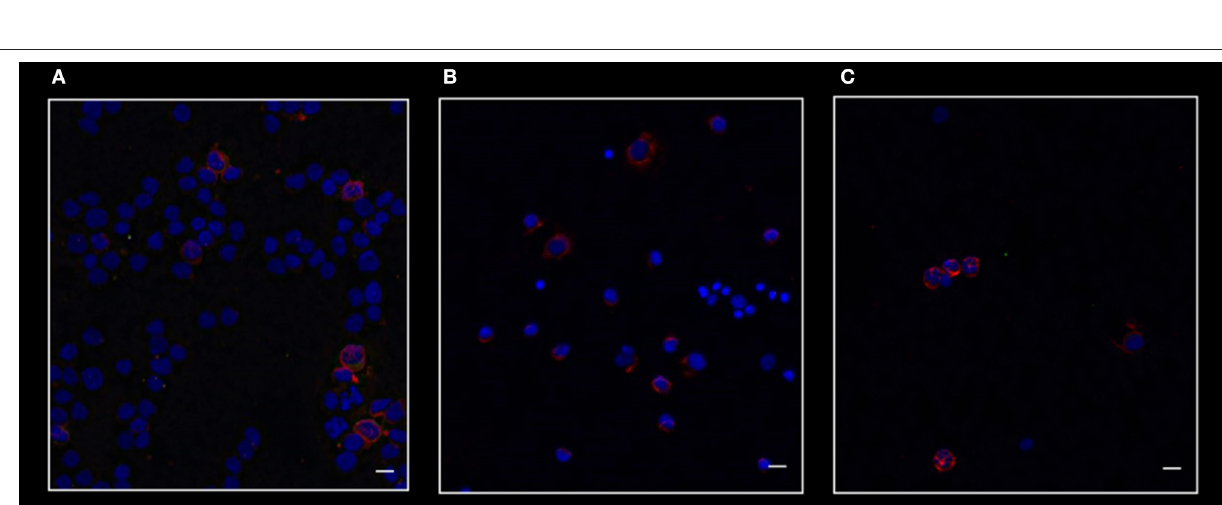
Frontiers in Oncology | www.frontiersin.org